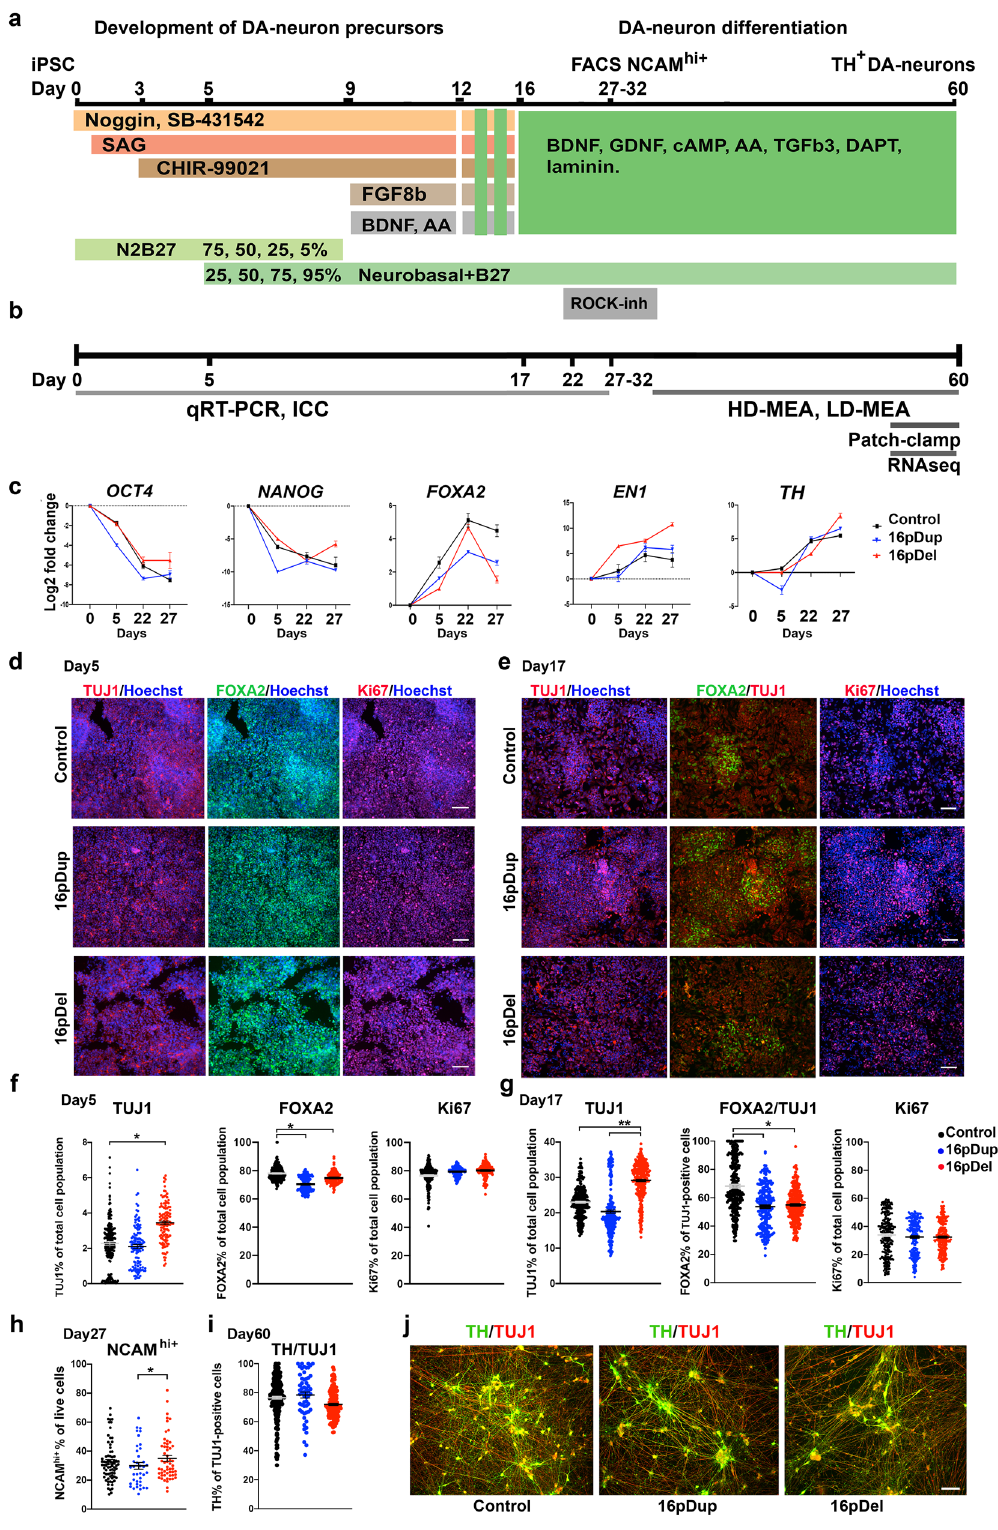
(smoothened agonist) was ef fi cient. Control cells expressed a higher level of FOXA2 compared to cells with 16p11.2 CNVs (Fig. 1d, f). At this stage of the differentiation, the number of TUJ1 (beta-tubulin III)-positive neurons was still low (2 – 3% from the total cell population), and the 16pdel cells had a signi fi cantly higher number of TUJ1-positive cells compared to the control cell population ( p < 0.05). At day 5 of differentiation, the cell